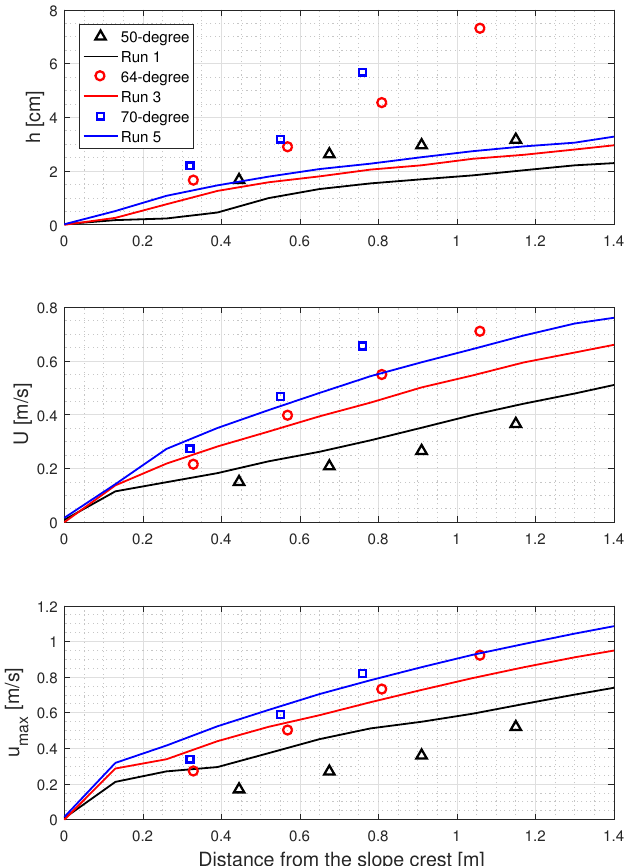
Figure 8. Comparison of spatial evolution of turbidity currents propagating over 50 ◦ , 64 ◦ , and 70 ◦ slopes: layer thickness development ( top ), layer-averaged velocity ( middle ), and layer-peak velocity U max ( bottom